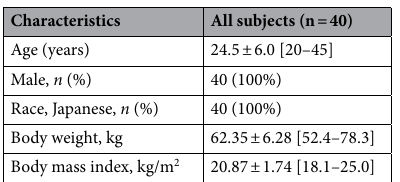
Table 1. Baseline characteristics of the study population (safety population). All average data are mean ± SD